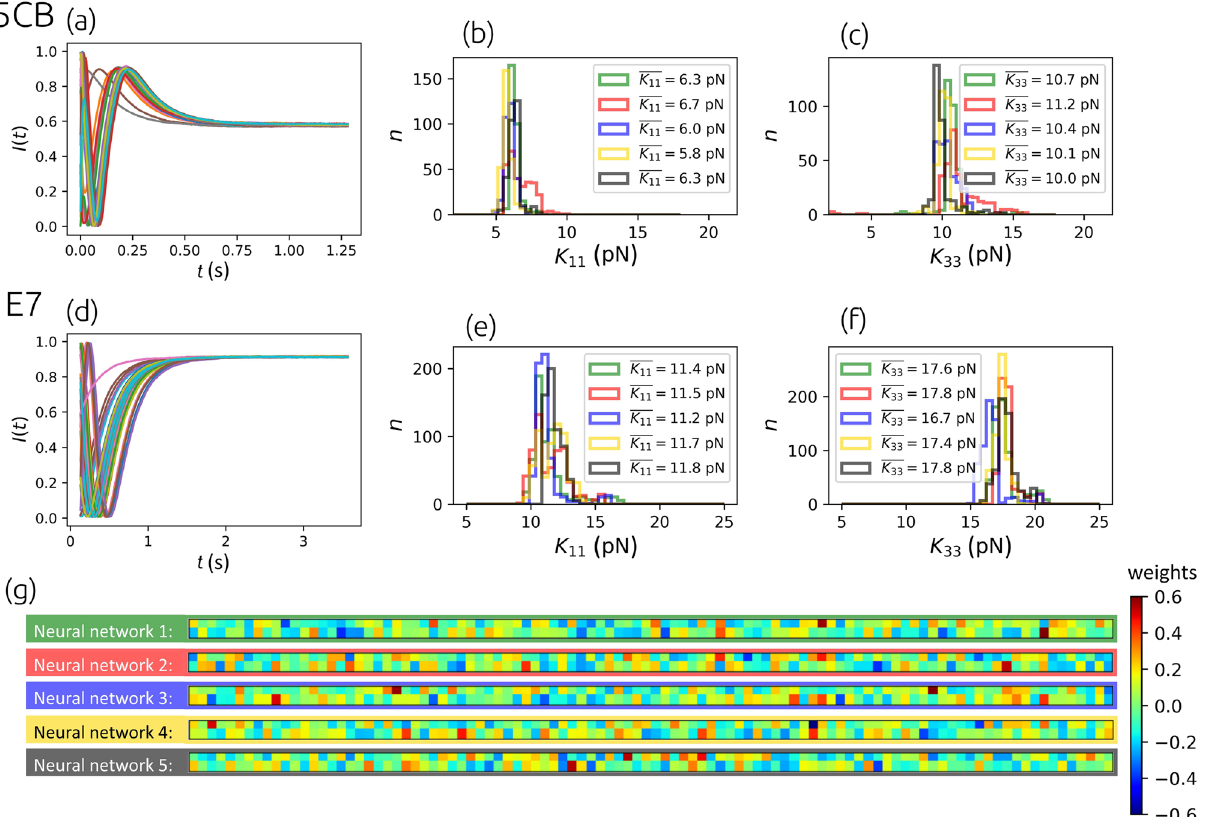
Figure 5. Results from experimentally measured data. Panels ( a ) and ( d ) show the measurements of the time- dependent intensities I ( t ) in 5CB and E7 at room temperature. Different curves correspond to different initial states of the director θ( z , t = 0 ) caused by random electric pulses. Panels ( b ), ( c ), ( e ), ( f ) show the distributions of elastic constants of 5CB and E7 determined by five independently trained neural networks for each material. The following parameters were used to build the training data sets in accordance with the experimental setup: ( i ) 5CB setup has D = 10 µ m , γ 1 = 0.098 Pa s 37,38 , n o = 1.5450 , n e = 1.7400 46–48 , (cid:31) = 505 nm , σ (cid:31) = 20 nm , K 11 and K 33 range in the training data set U ( 2 pN, 18 pN ) , and (ii) E7 setup has D = 15 µ m , γ 1 = 0.200 Pa s 49 , n o = 1.5225 , n e = 1.7435 48 , (cid:31) = 595 nm , σ (cid:31) = 8 nm , K 11 and K 33 range in the training data set U ( 5 pN, 25 pN ) . Panel ( g ) shows the values of transposed matrices of weights between the last hidden layer and the output layer of five independently trained neural networks that were used to predict elastic constants of the E7 sample. All five neural networks had the same architecture and identical training hyperparameters (learning rate, batch size, number of epochs, etc.), and the same training data were used. This illustrates that there exist, due to a large number of model parameters (weights and biases) and random initialization of them, many neural networks with completely different combinations of weights that still result in very similar outputs of the